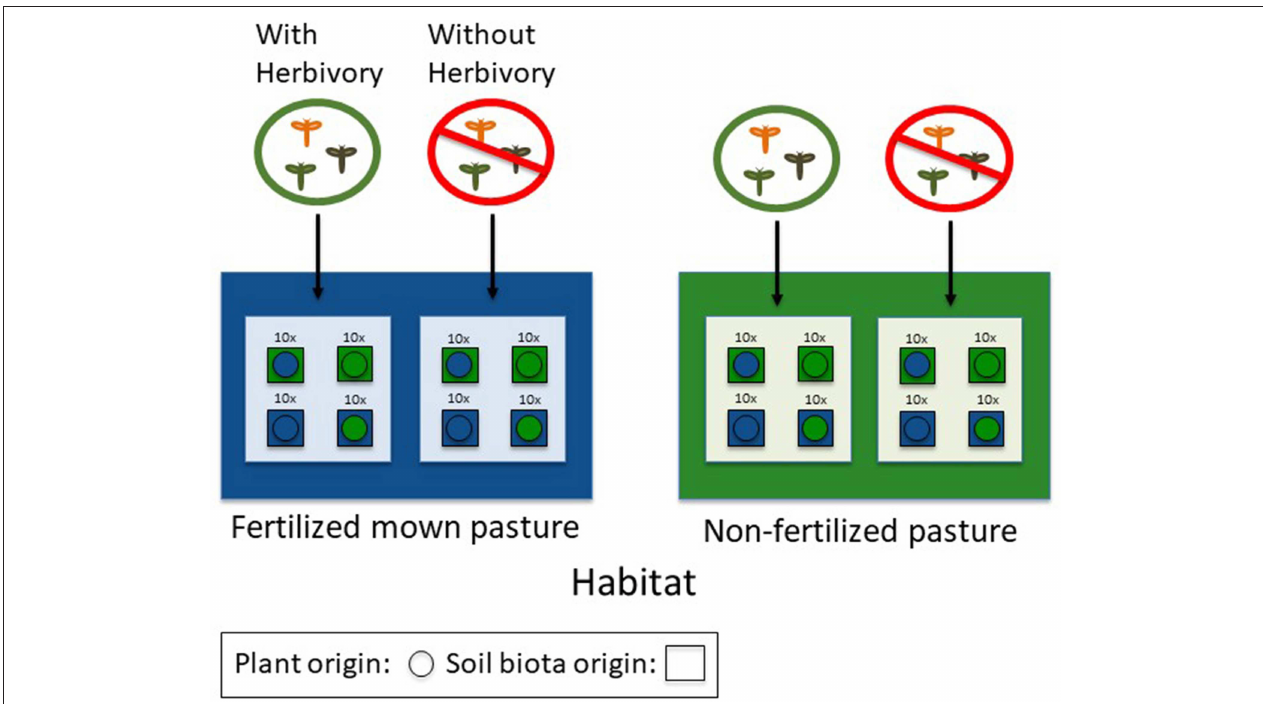
FIGURE 1 | Conceptual diagram of the experimental design. In three pairs of contrasting habitats (non-fertilized pastures vs. fertilized mown pastures) plants (circles) of different origin were reciprocally transplanted and grown in their home and away soils (squares) in the presence and absence of aboveground insect herbivores.